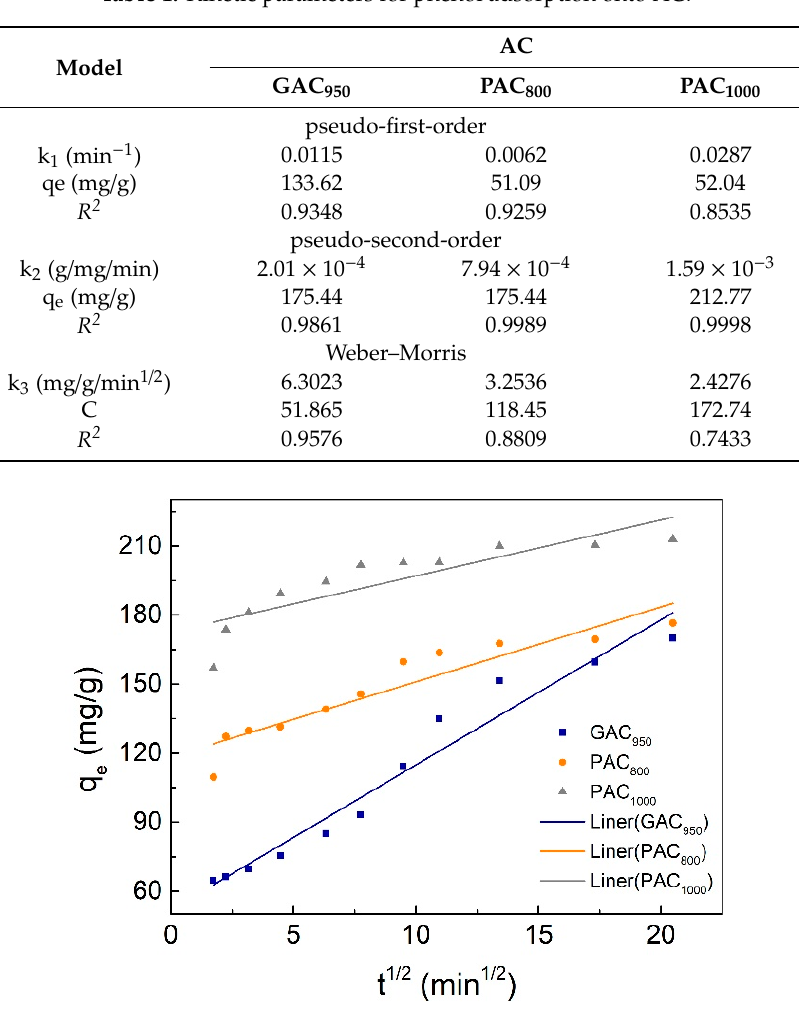
Figure 5. Weber-Morris plot for phenol adsorption onto activated carbons (AC). Table 1. Kinetic parameters for phenol adsorption onto AC.